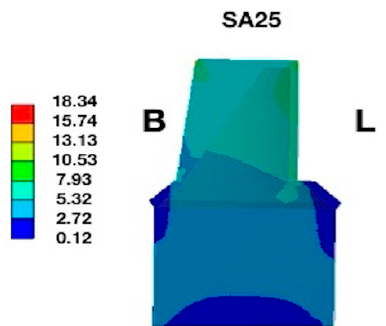
Figure 5. A cross-section of the finite element (FE) model with specimen set on the implant abutment. Using SA25 as an example, stress distribution of the whole model was shown. The maximum stress value was located on the occluso-lingual axial wall of the specimens when vertical forces were applied .